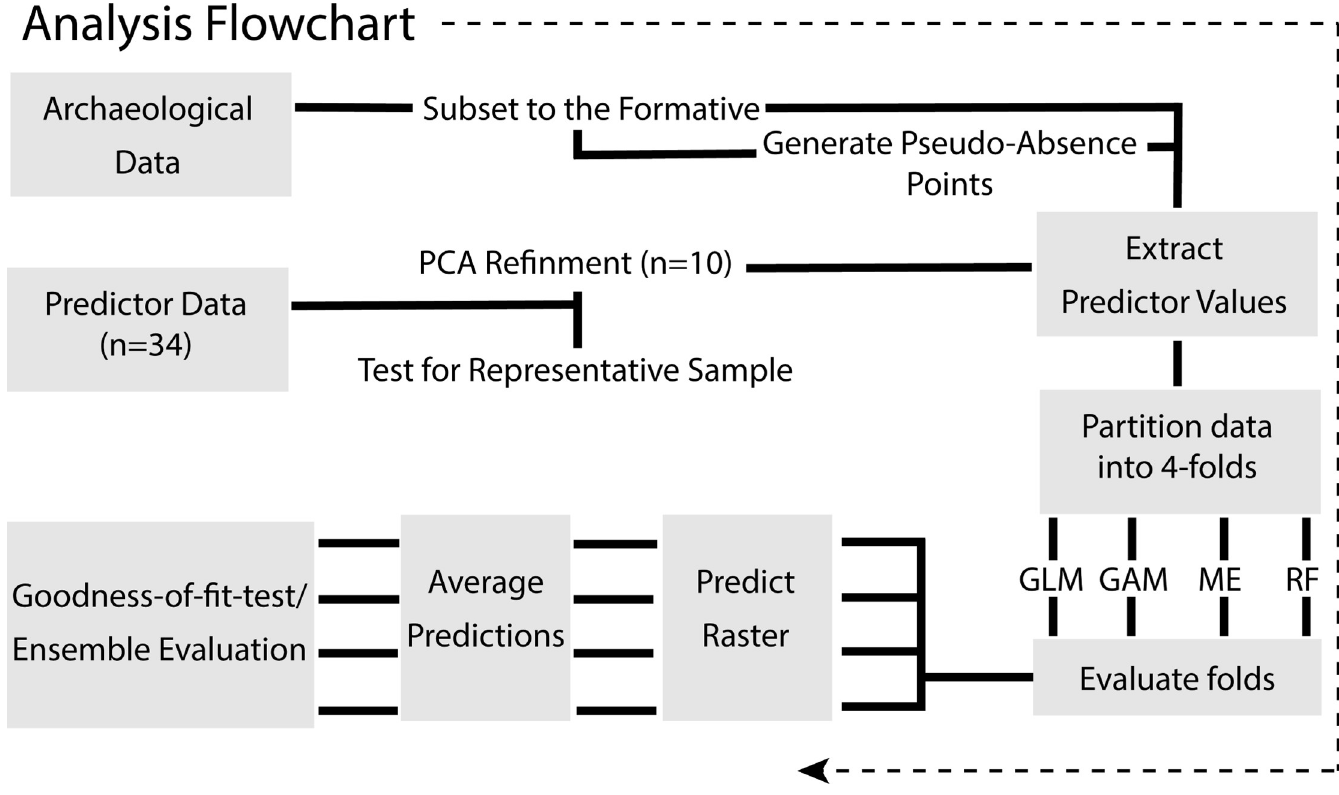
Fig 2. Flowchart of